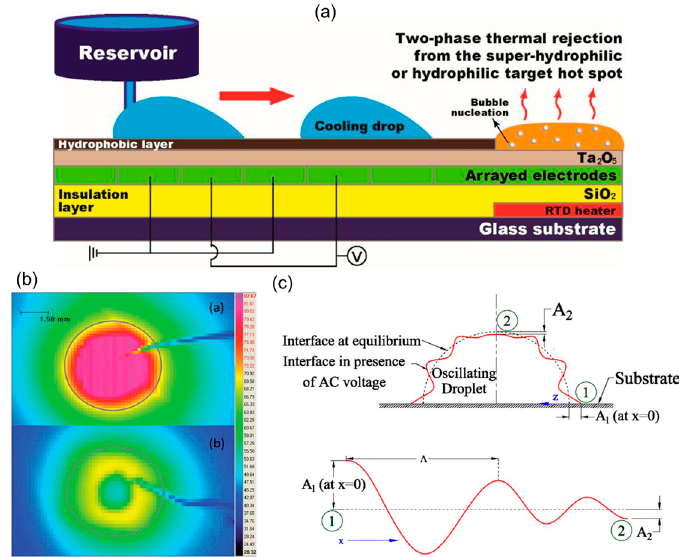
Figure 5. ( a ) Schematic of the single-sided digital microfluidic (SDMF) device and the working principle of effective liquid delivery and two-phase cooling; Reproduced with permission from [50]; published by MDPI, 2017. ( b ) schematic of oscillating droplet with the surface wave. Reproduced with permission from [55]; published by ELSEVIER, 2017; ( c ) temperature distributions at and around the hot spot with (bottom) and without (top) oscillating droplet. Reproduced with permission from [54]; published by The Royal Society of Chemistry,